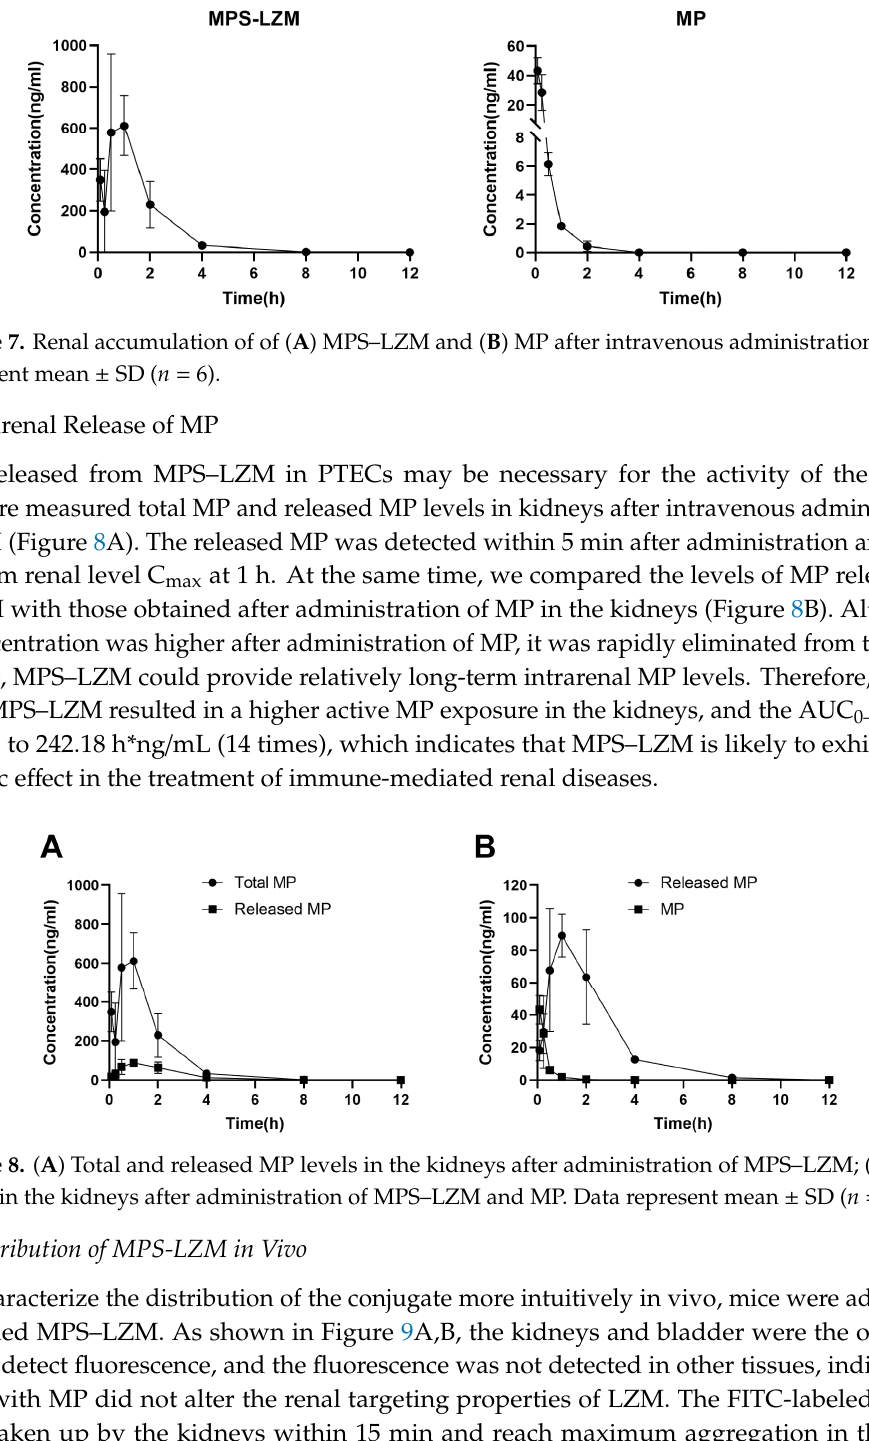
Figure 7. Renal accumulation of of (A) MPS–LZM and (B) MP after intravenous administration. Data represent mean ± SD ( n = 6). Table 2. Pharmacokinetic parameters of MP and MPS–LZM in kidneys after a single intravenous injection.